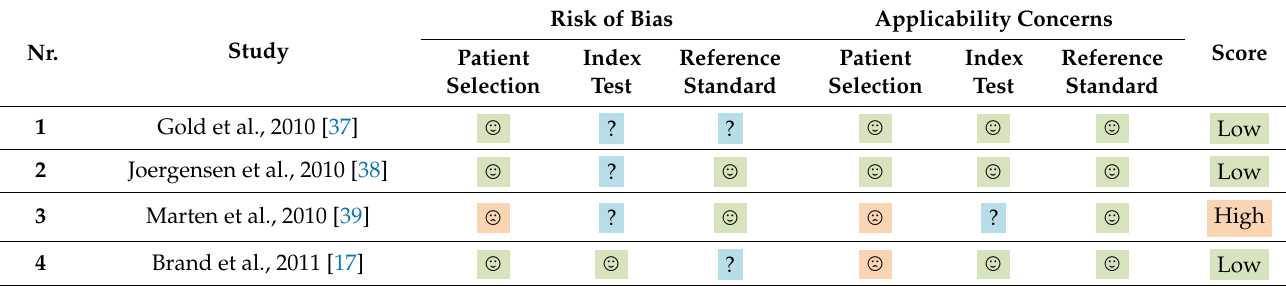
Table A1. Graphical summary of the QUADAS-2 scores for each of the 49